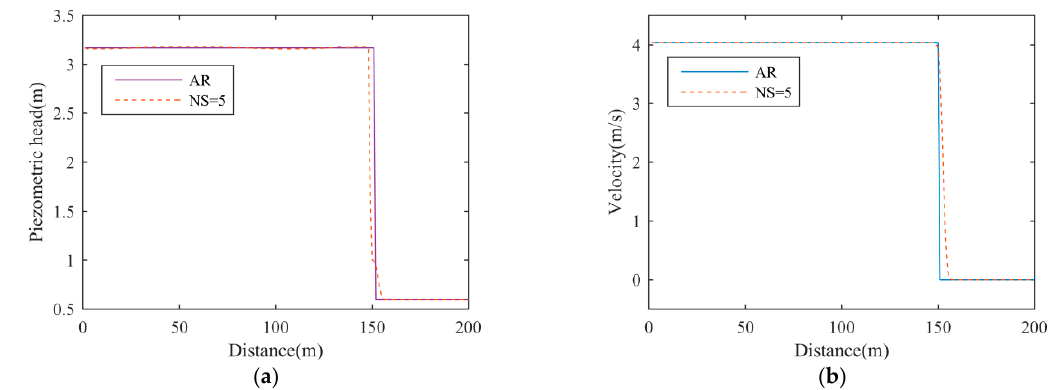
Figure 6. Comparison of the results simulated by M_HLL, with K a = 1.4 and NS = 5, and the analytical result (AR): ( a ) piezometric head; ( b ) flow velocity.